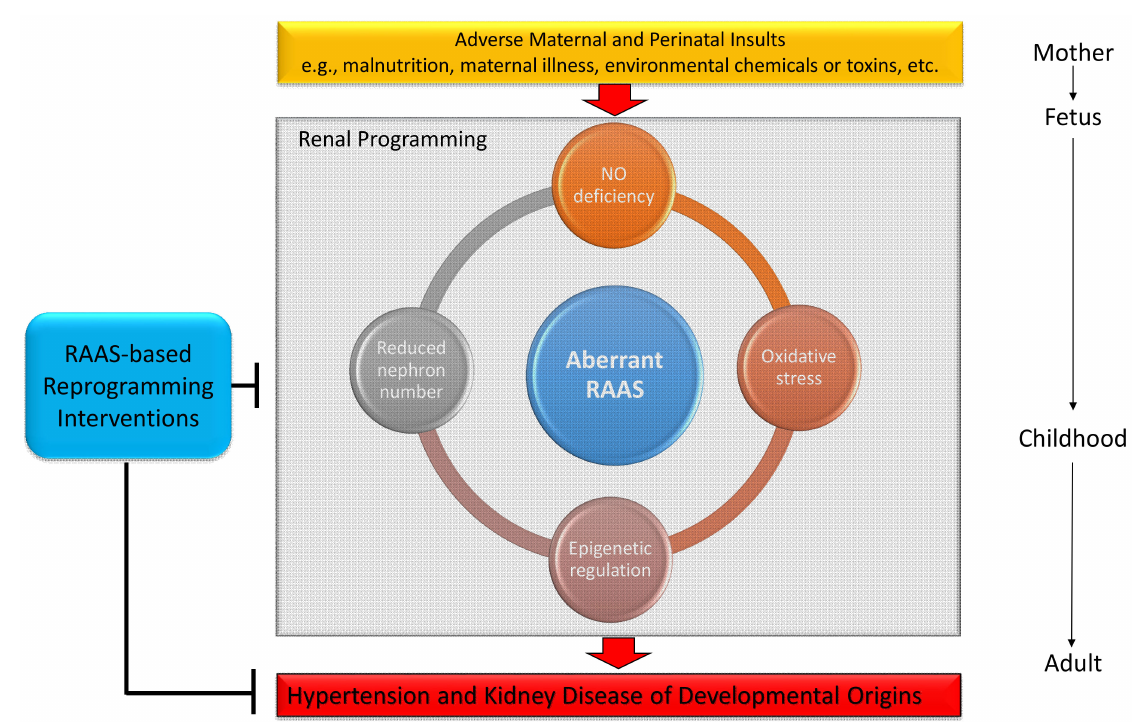
Figure 3. Schema outlining the central role of RAAS on mediating other mechanisms in the kidney leading to hypertension and kidney disease of developmental origins in response to a variety of maternal insults. Target on the RAAS-based interventions could be reprogramming strategies to prevent hypertension and kidney in adult offspring. NO, nitric oxide; RAAS, renin-angiotensin-aldosterone